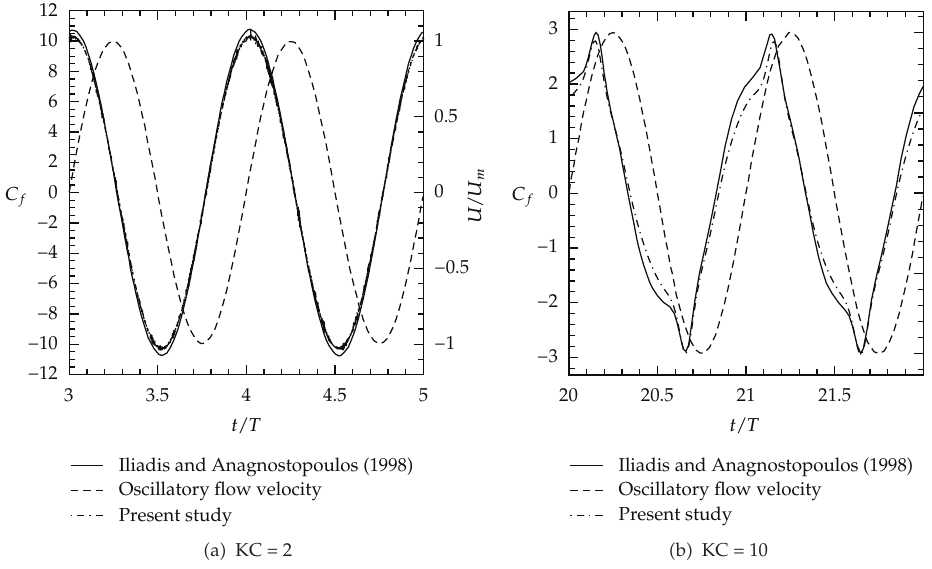
Figure 5: Time histories of C f at (cid:3) a (cid:4) KC (cid:8) 2 and (cid:3) b (cid:4) KC (cid:8) 10.